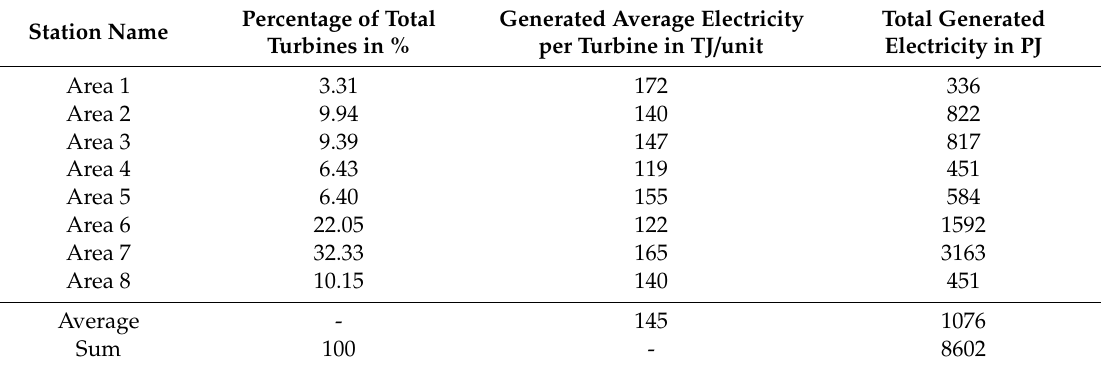
Table 4. Annual electricity generation potential per area (Hokkaido,